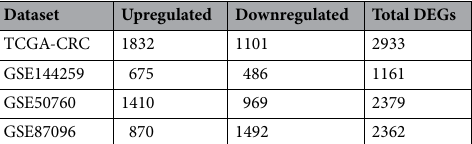
Table 2. Total number of DEGs in all the CRC